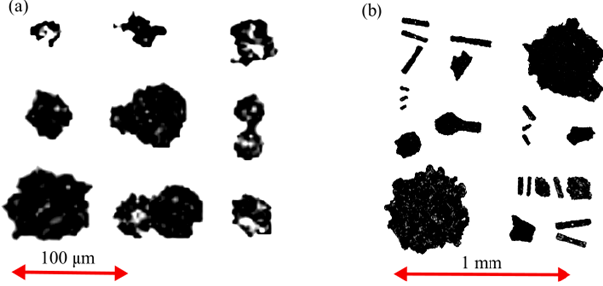
Figure 7. Holographic imagery, indicating ice crystals, from pene- trations 1 and 4 (case